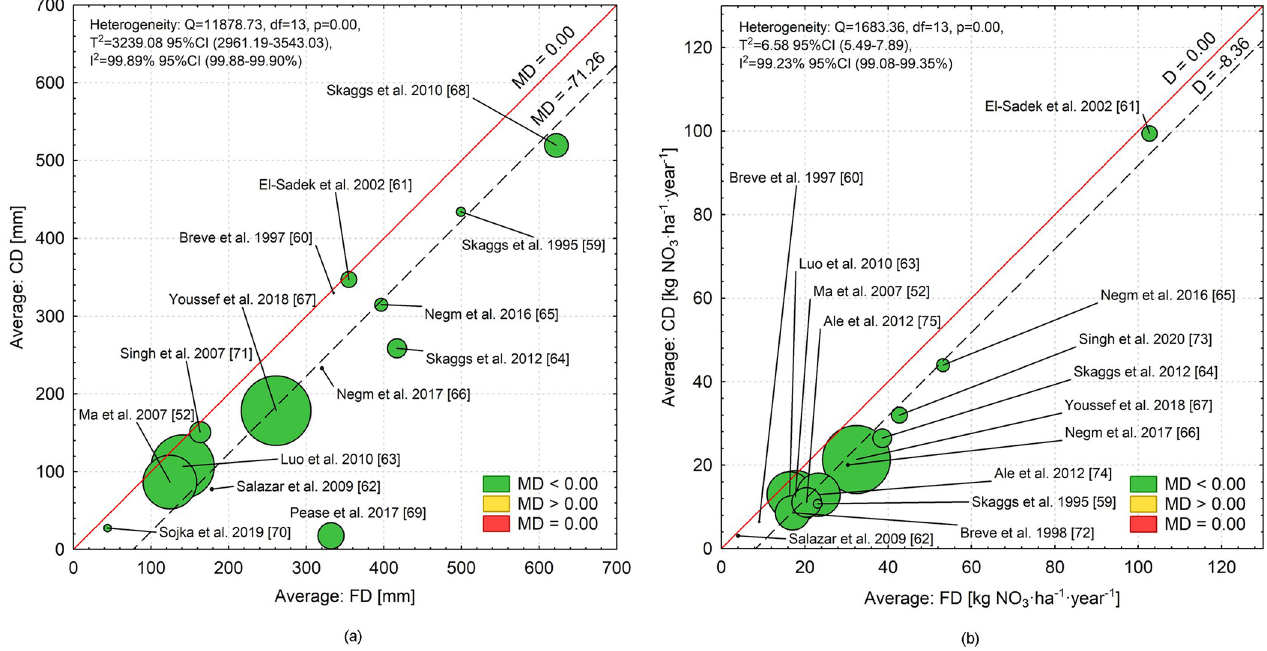
Fig 5. Heterogeneity analysis for all articles based on L’Abbe´ plot: (a) subsurface drainage outflow reduction by CD versus FD; (b) nitrate load in drainage outflow by CD versus FD.